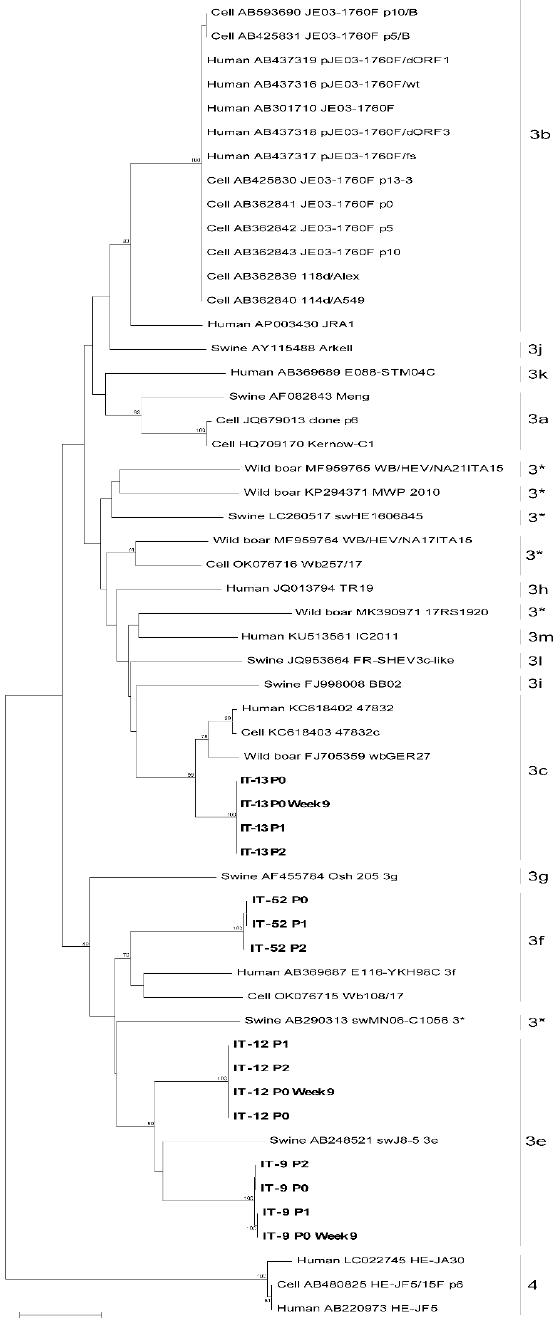
Figure 5. Maximum Likelihood phylogenetic tree built with 15 HEV ORF2 partial sequences obtained from this study (indicated in bold), 18 HEV-3 reference sequences, 21 HEV from strains isolated on cells and one HEV-4 sequence as outgroup. 3*: unassigned subtypes.